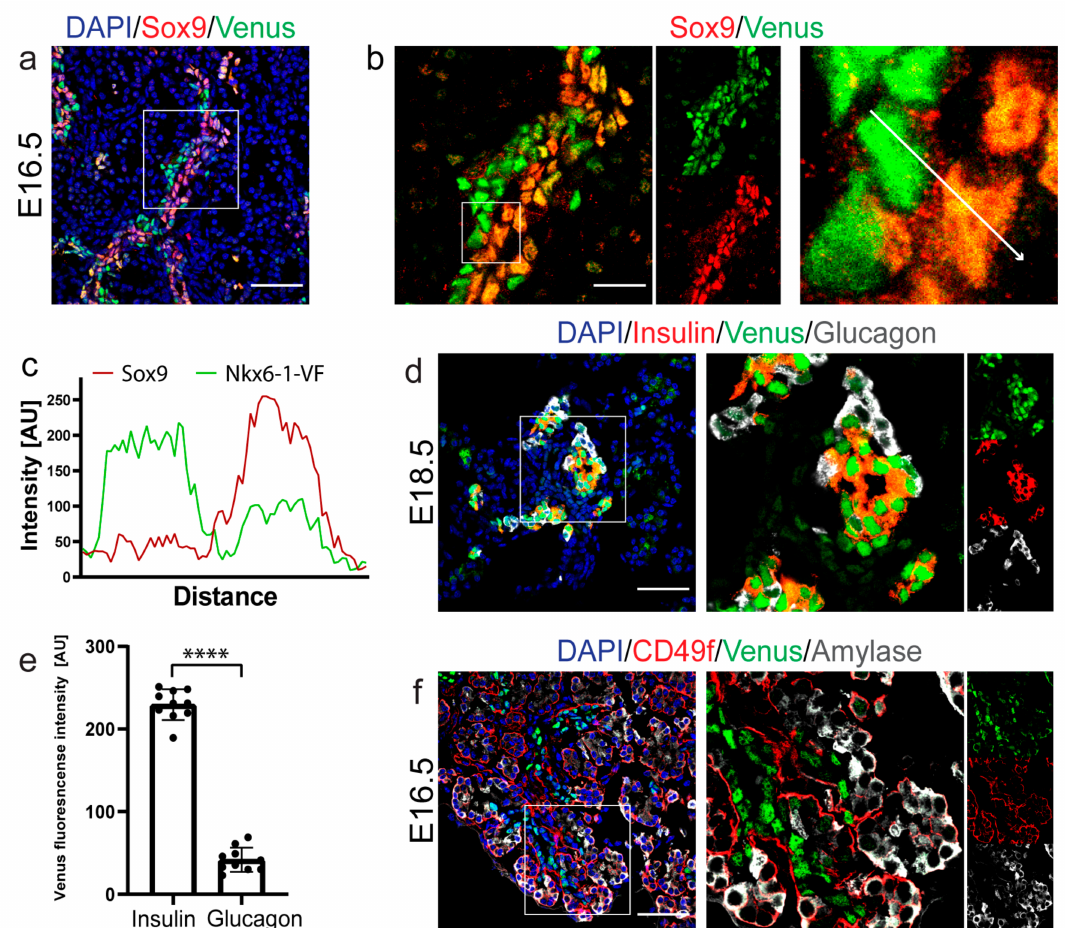
Figure 3. Nkx6-1-VF marks the endocrine lineage during secondary transition. ( a , b , f ) Immunostaining of E16.5 and ( d ) E18.5 pancreas section exhibiting Nkx6-1-VF expression during endocrine cell formation and β -cell lineage specification. Scale bar 50 µ m. ( b ) Immunostaining analysis of E16.5 pancreas (scale bar 20 µ m) shows that Nkx6-1-VF expression is expressed ( c ) at low levels in the duct (Sox9+/Nkx6-1-VF low) and high levels near the duct (Sox9-/Nkx6-1-VF high), ( f ) but not in the exocrine cells marked by amylase. ( d , e ) At E18.5, the Nkx6-1-VF high expression levels correlate with endocrine lineage formation and mark insulin-secreting cells. Scale bar 50 µ m. *** p < 0.0001; t